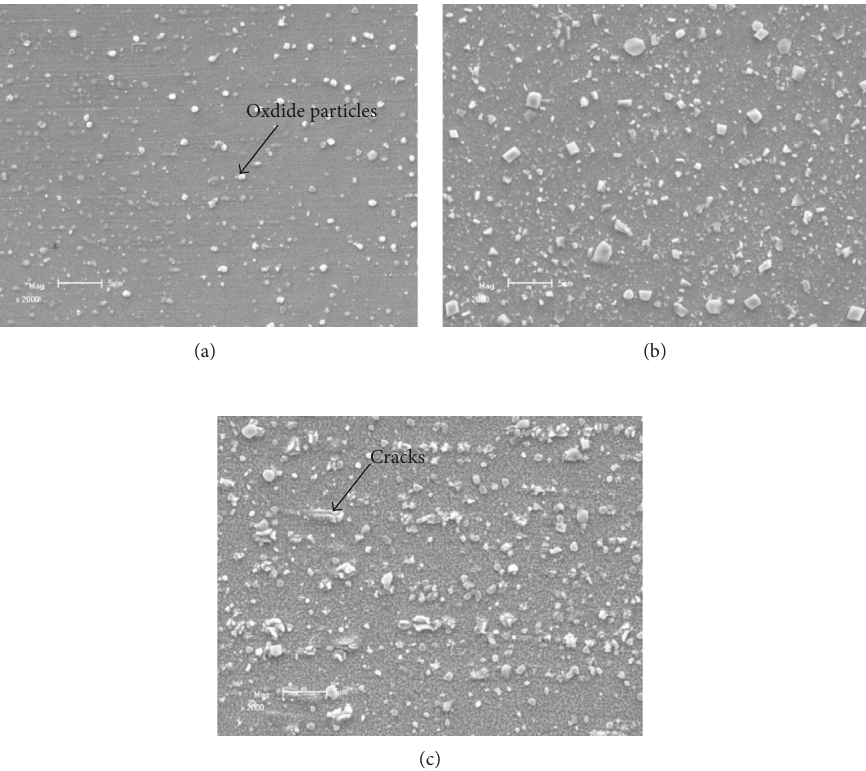
Figure 3: SEM morphologies of the oxide film formed on Alloy C-276 exposed to SCW for (a) 50h, (b) 250h, and (c) 500h.